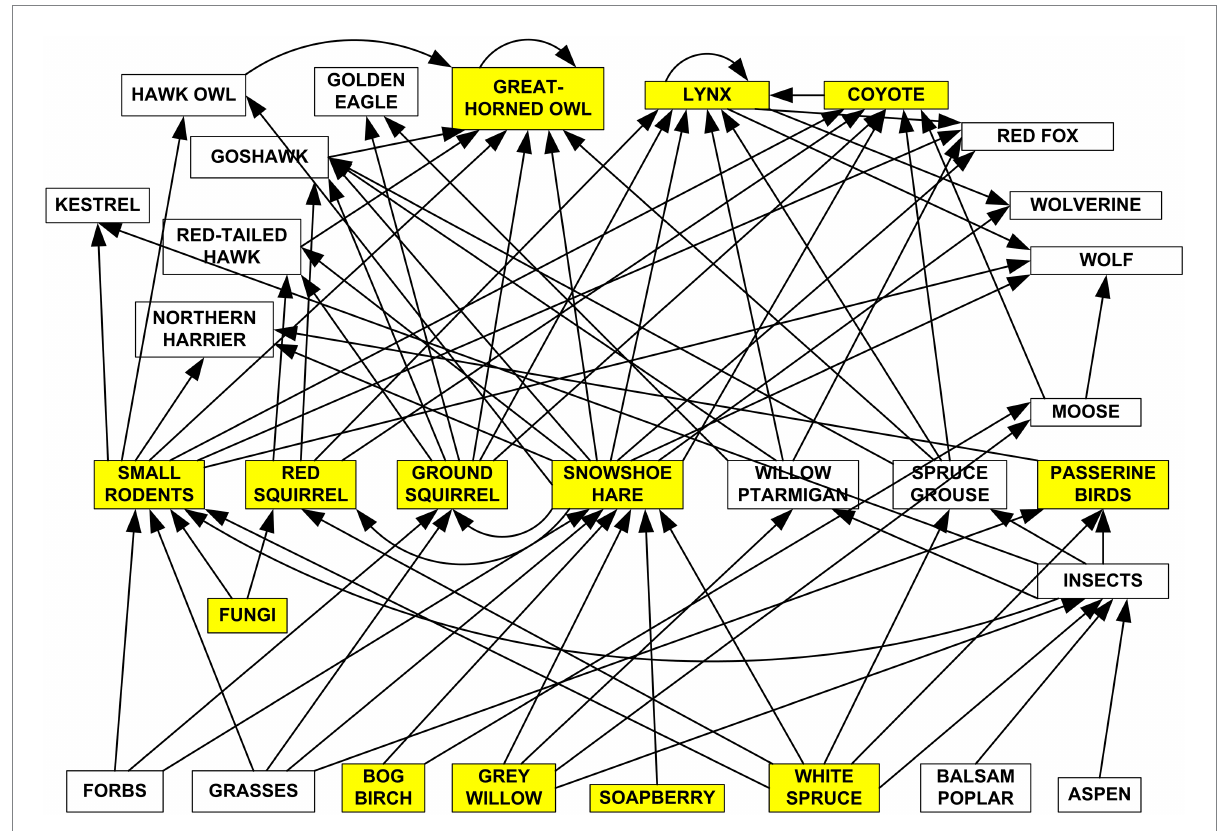
FIGURE 3 Simplified food web for the boreal forest at Kluane Lake, Yukon. All these species and species groups have been studied but the shaded taxa have had the majority of the research focus [revised from Krebs et al., 2001, Figure 2.8]. The complexities implied in this relatively simple food web is